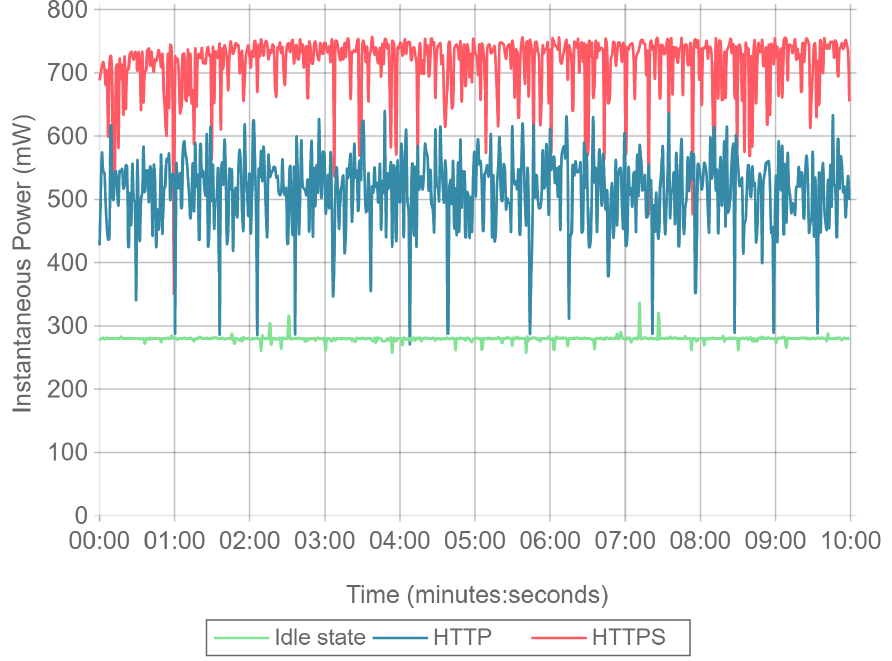
Figure 7. Power consumption during 10 min for idle state and 16 concurrent clients accessing a 512byte payload served by Nginx using HTTPS and